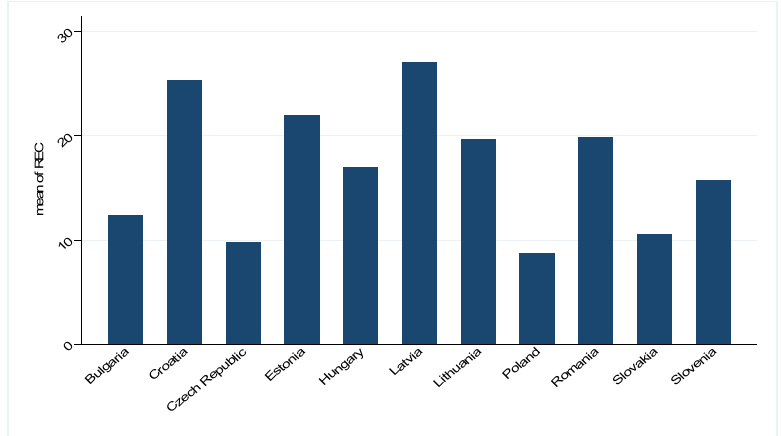
Figure 1. Mean values of renewable energy consumption (% of total final energy consumption).